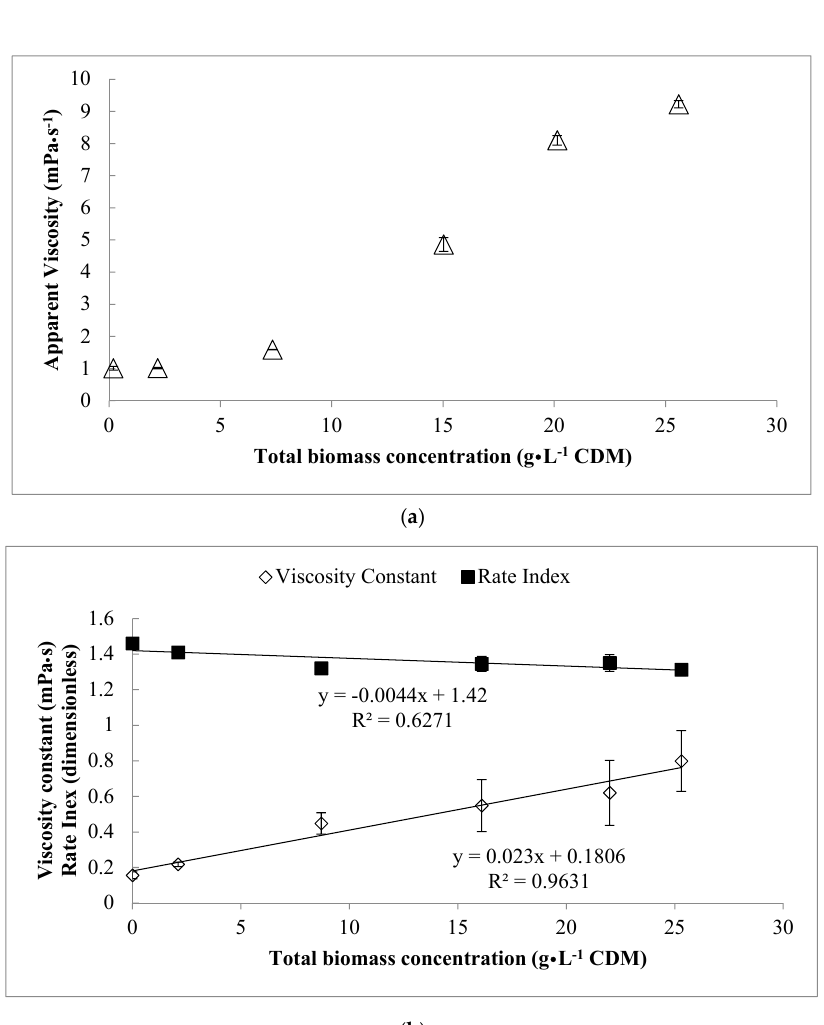
Figure 3. ( a ) Changes in apparent viscosity of the P. putida LS46 culture with increasing total biomass concentration over time and ( b ) changes in power-law constants describing culture rheology as a function of the total biomass in the (pilot-scale) fed batch cultivation at varying points over time. Error bars represent the standard deviations between technical replicate measurements ( n = 3).